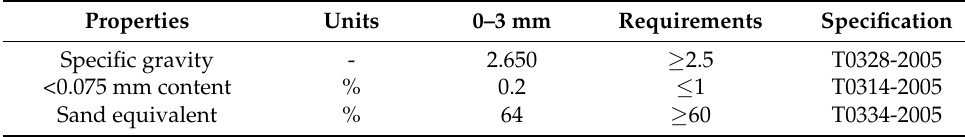
Table 3. Basic performance indicators of fine basalt